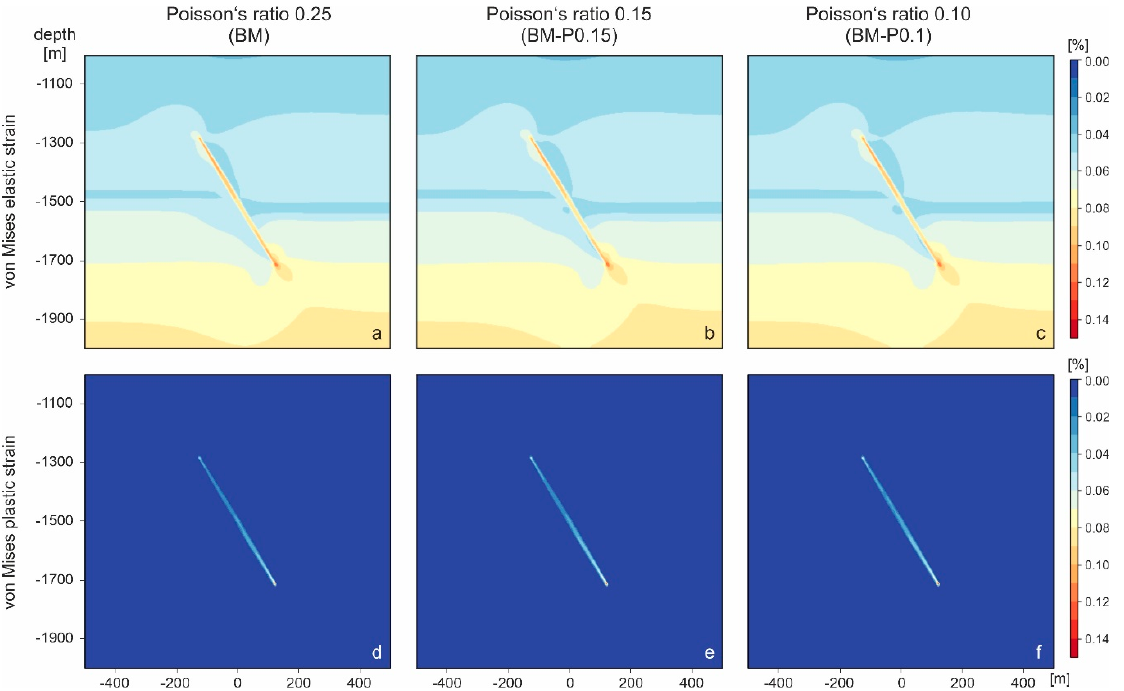
Figure 7. Spatial variations in the van Mises elastic ( a – c ) and plastic strain ( d – f ) after five years of injection for three different Poisson’s ratios assigned to the fault zone.